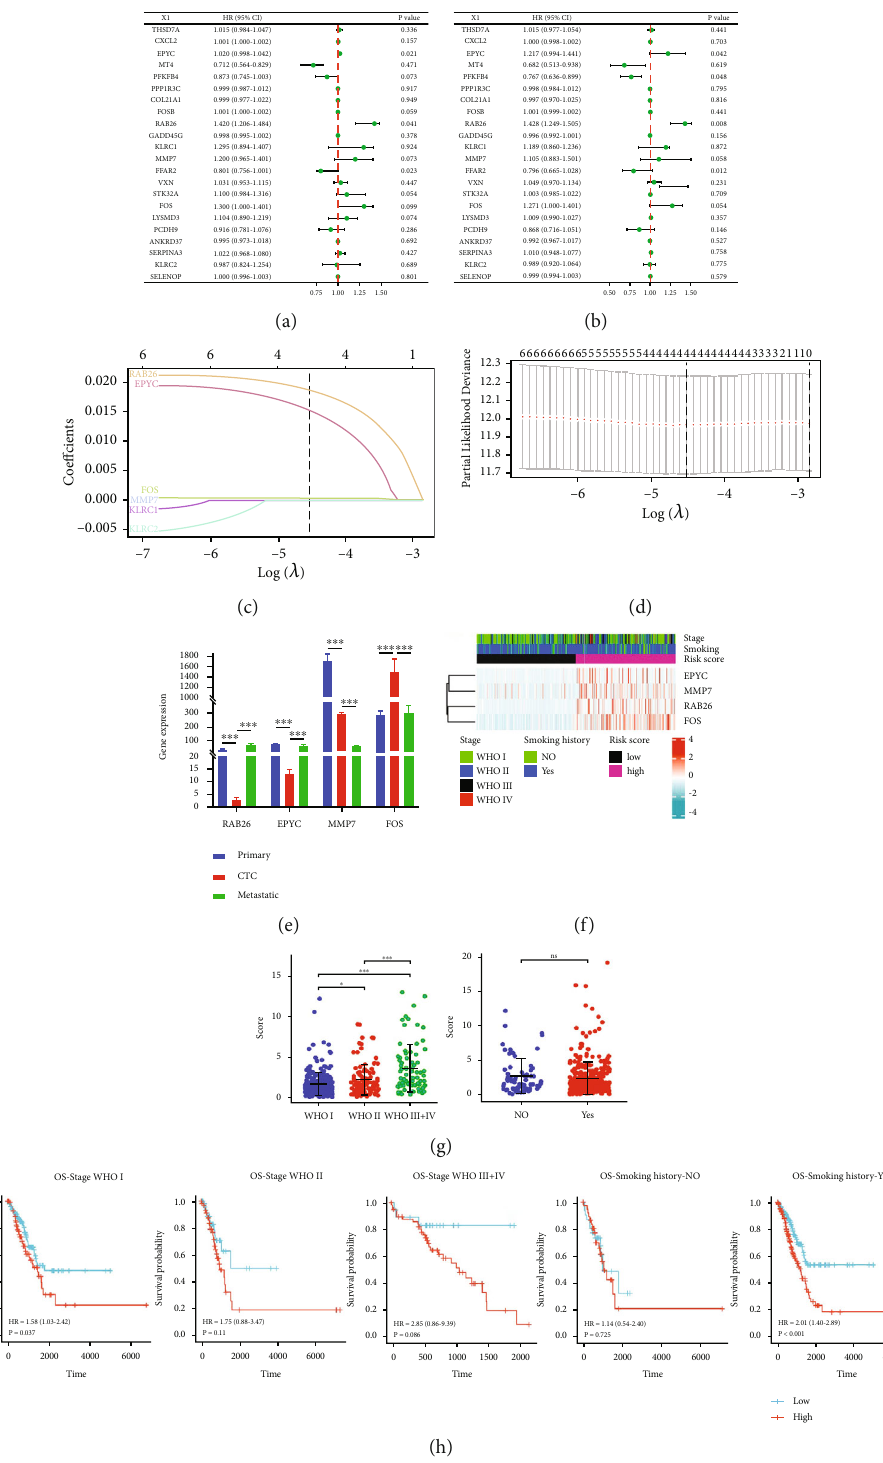
Figure 3: Establishment of the CTCR model in TCGA-LUAD cohort (n =447). (A, B) Univariate and multivariate Cox regression analyses were used to examine the correlation between DEGs and OS. (C) LASSO coe ffi cient pro fi les of 6 DEGs. (D) Cross-validation revealed an optimum parameter of 4 in the LASSO model. (E) The relative expression of 4 risk genes in the primary tumour, CTCs and metastasis. (F) Unsupervised clustering of the 4 candidate genes using the tumour stage, smoking history and risk score as patient annotations. (G) Dot chart re fl ecting the risk scores of samples grouped based on the clinical stage and smoking history (H) Prognostic value in the high- and low-risk groups of di ff erent clinical subgroups (tumour stages and smoking history). The asterisks represent the statistical p -value ( ∗ p < 0 : 05 ; ∗∗ p < 0 : 01 ; ∗∗∗ p < 0 : 001